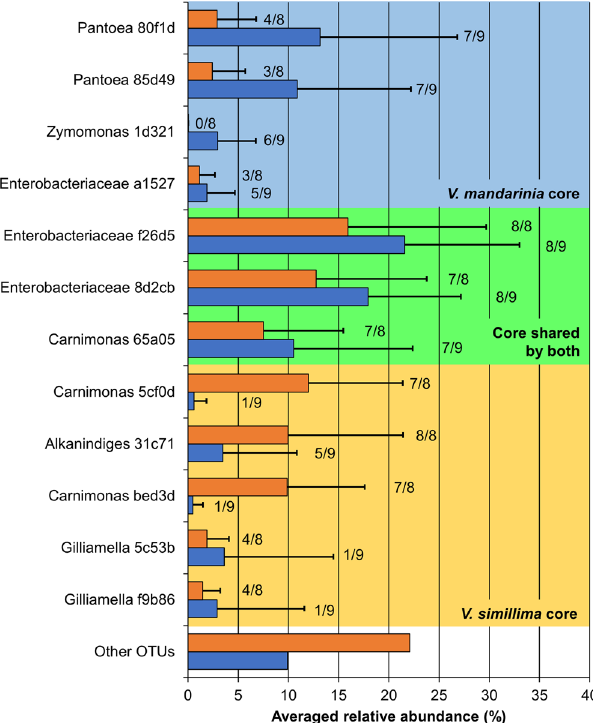
Figure 5. Relative abundance of core OTUs in V. mandarinia and V. simillima . When an OTU was detected in both locations and from at least 50% of samples at a relative abundance greater than 1%, it was defined as core. Bars indicate averaged relative abundances of core OTUs with standard deviations in V. mandarinia (blue) and V. simillima (orange). The ratio of samples containing each core OTU is shown on the right of each bar. The OTU IDs are shortened to the last five characters. Taxonomy of OTUs is assigned based on SILVA (also see Table 2). Bar colors; blue, V. mandarinia ; orange, V. simillima . Core OTUs unique to V. mandarinia , unique to V. simillima , and shared by both are highlighted in blue, yellow, and green,